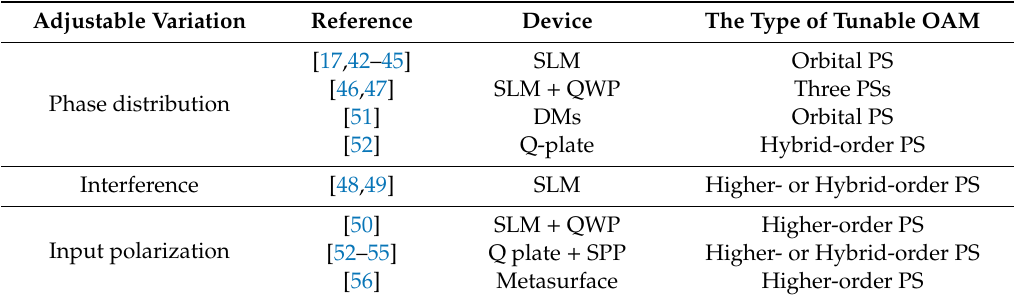
Table 1. The free-space generation methods.